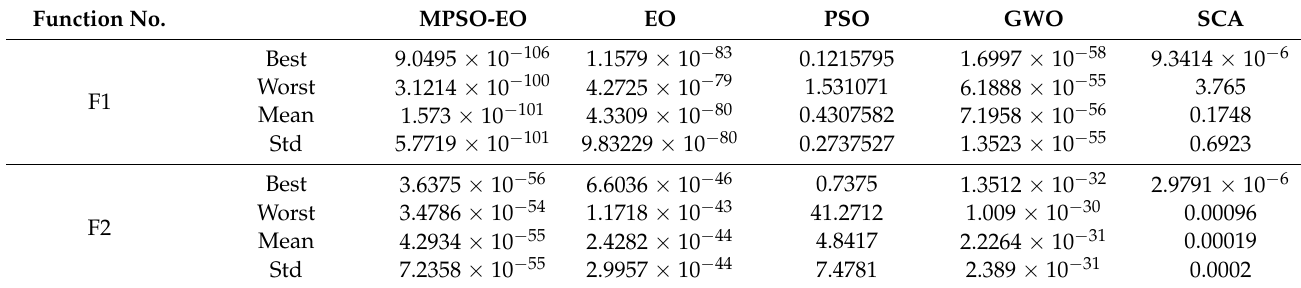
Table 1. Comparison for benchmark test functions